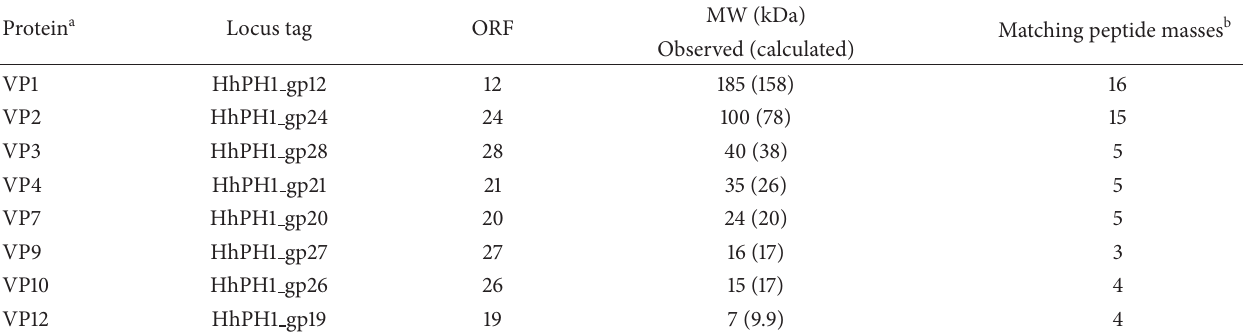
a Virus capsid proteins are numbered according to their similarity with SH1 capsid proteins. b